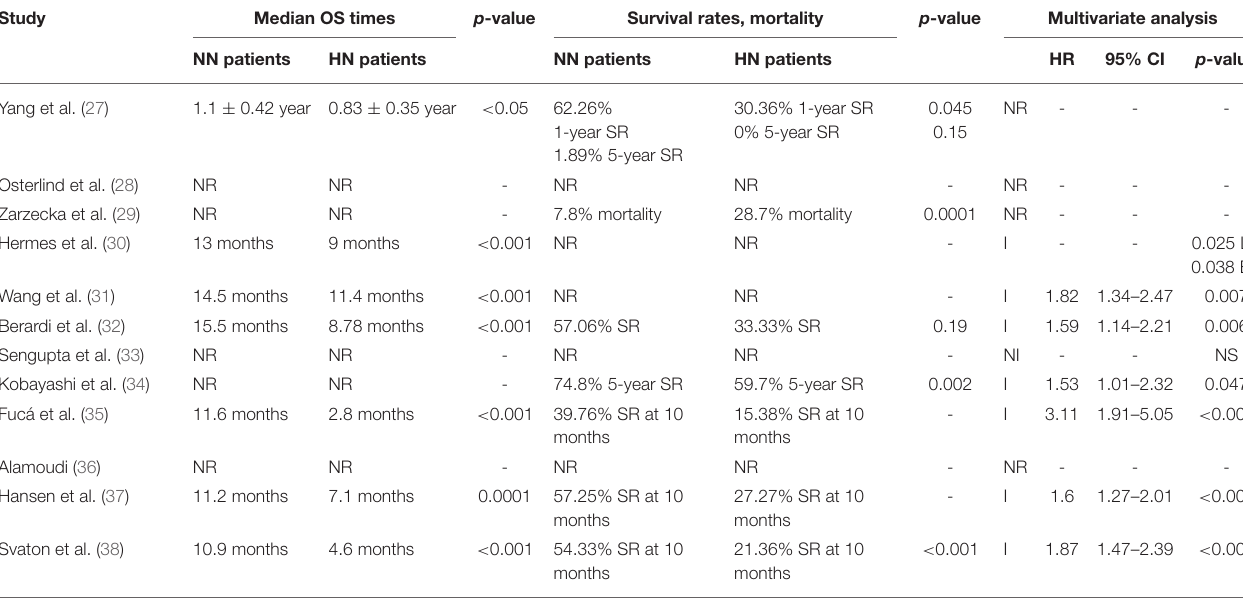
TABLE 3A | The outcomes in lung cancer patients among the included studies.